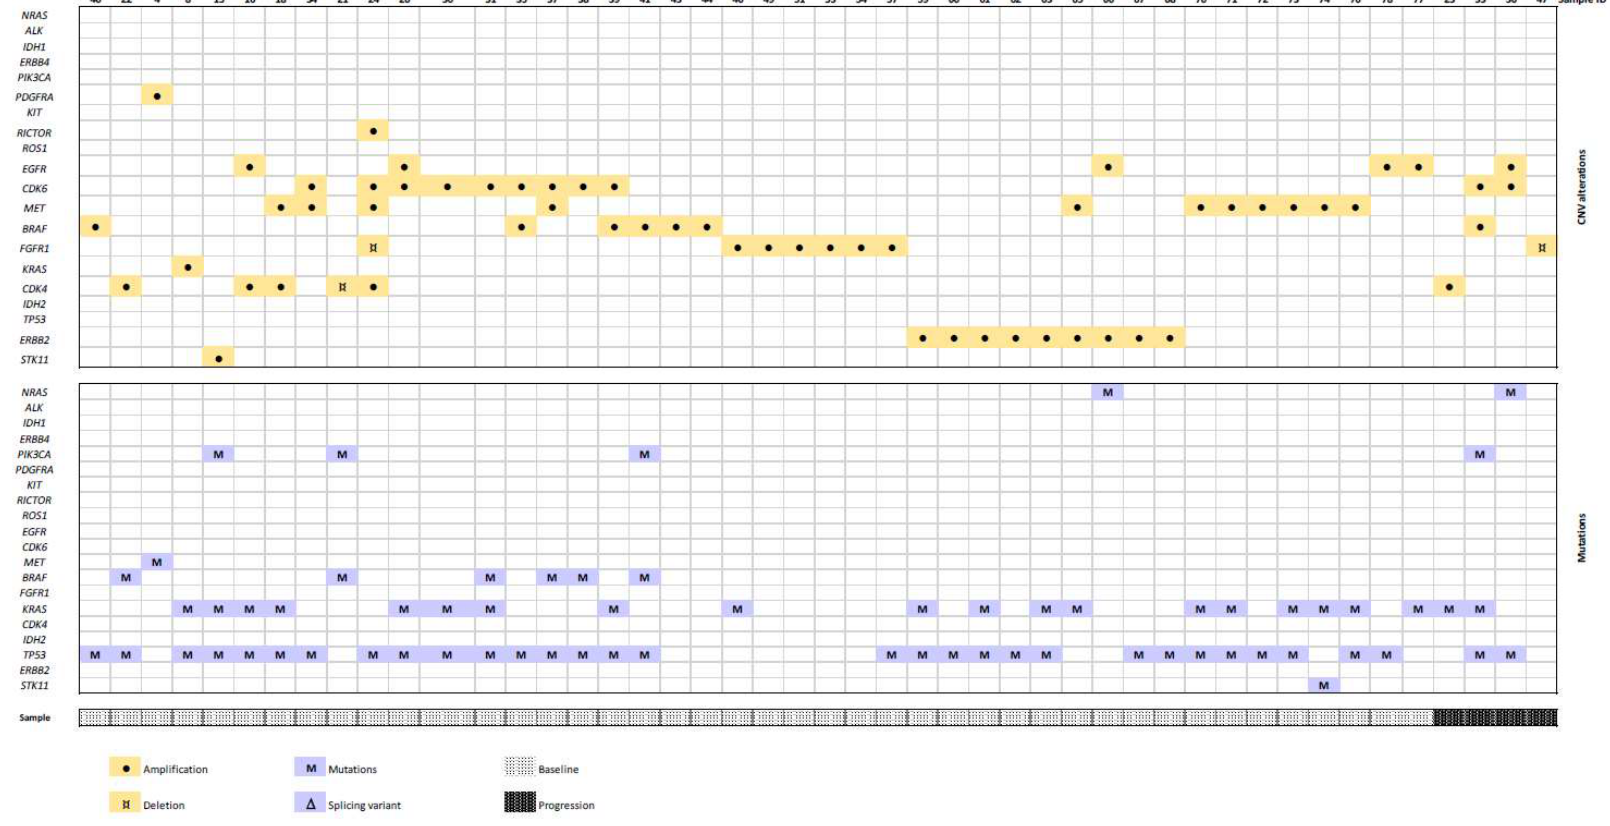
Figure 4. Heatmap of genetic alterations (mutations and CNVs) in CRC cohort.